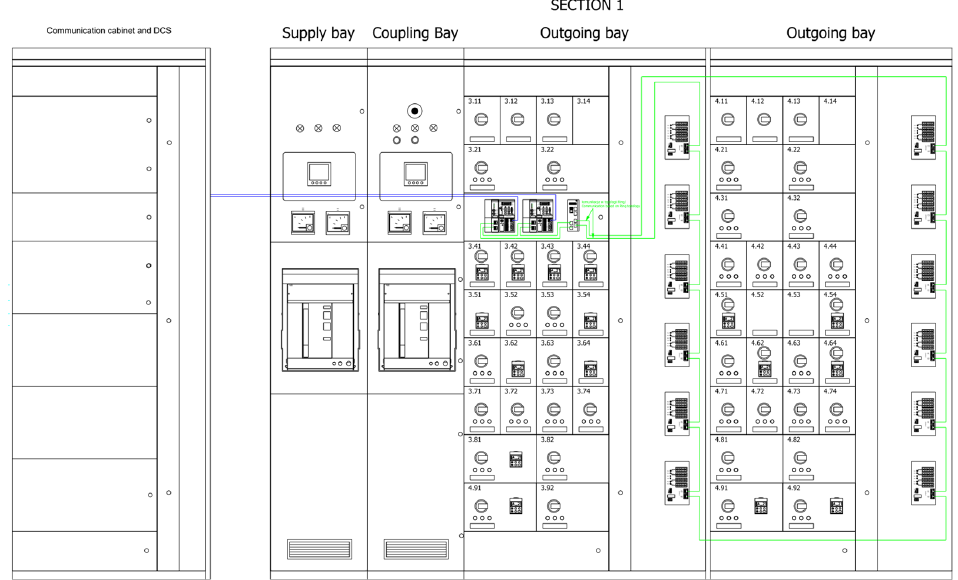
Figure 4. Detailed topology of the ring-type connection system in low-voltage switchgears based on two main PLC controllers in order to maintain the highest system reliability (Section 1).